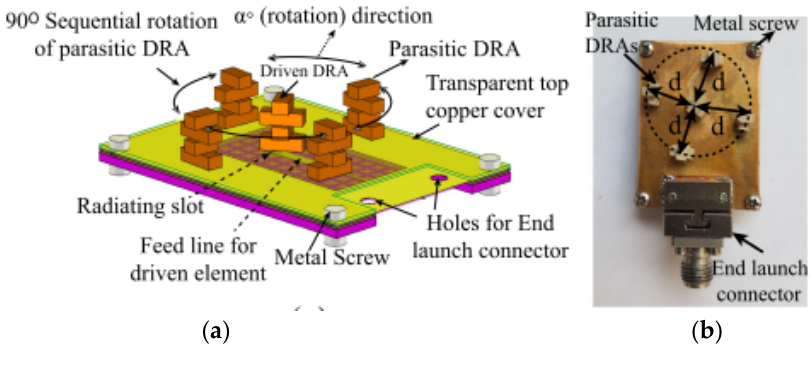
Figure 17. Parasitic DRA: ( a ) 3D view; ( b ) fabricated antenna [76].